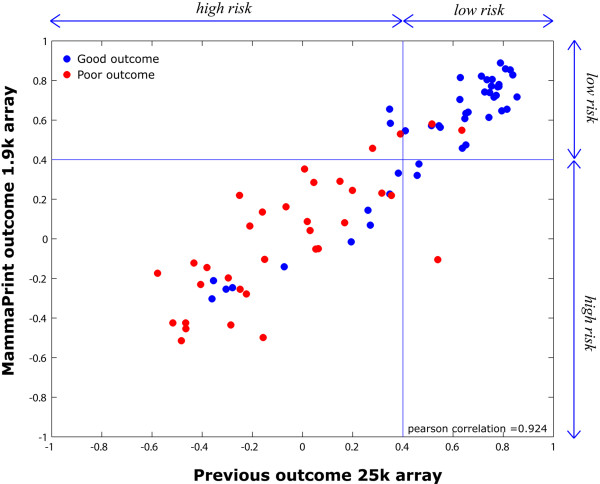
Comparison of current data to published values [6]. Correlation of the 70 genes from each tumor to the average expression profile of the good outcome patients is plotted. On the Y axis results from the customized 8-pack test is plotted and on the X axis results are plotted using published data from the original paper [6] using Xdev values (see text)